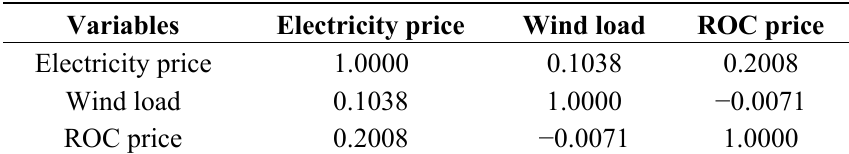
Table 5. Correlation matrix between state variables.